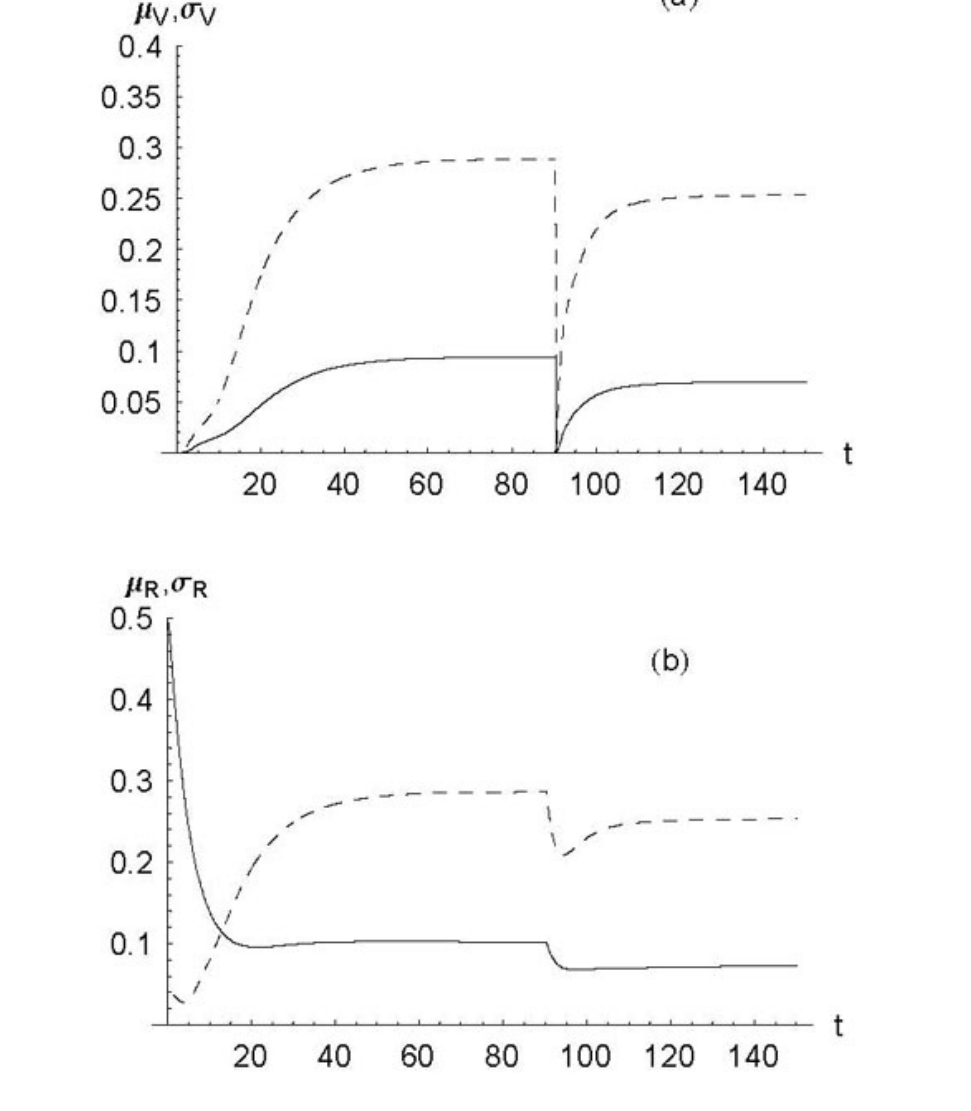
, m ) and standard deviations ( s , V R V / V and s / R , increase. Similar analyses V R